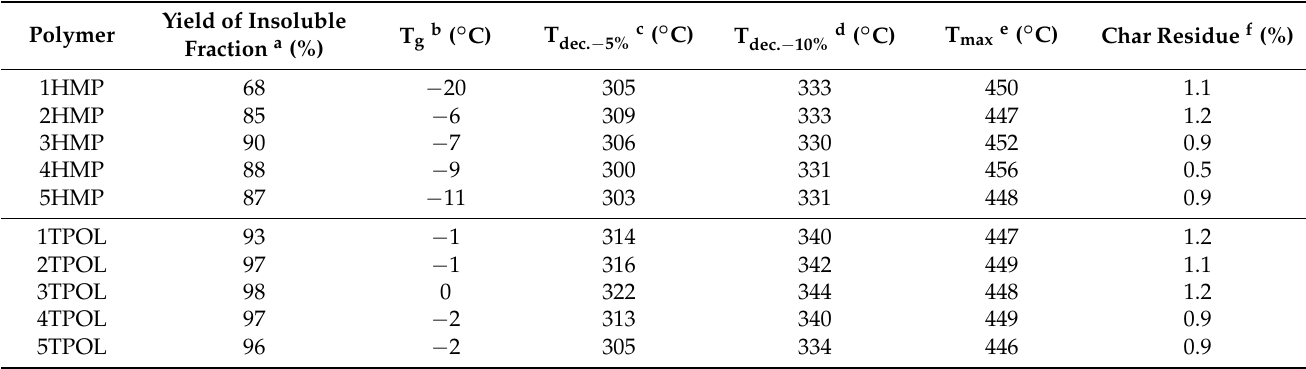
Table 2. Thermal characteristics and yield of insoluble fraction of the crosslinked polymers. Yield of Polymer